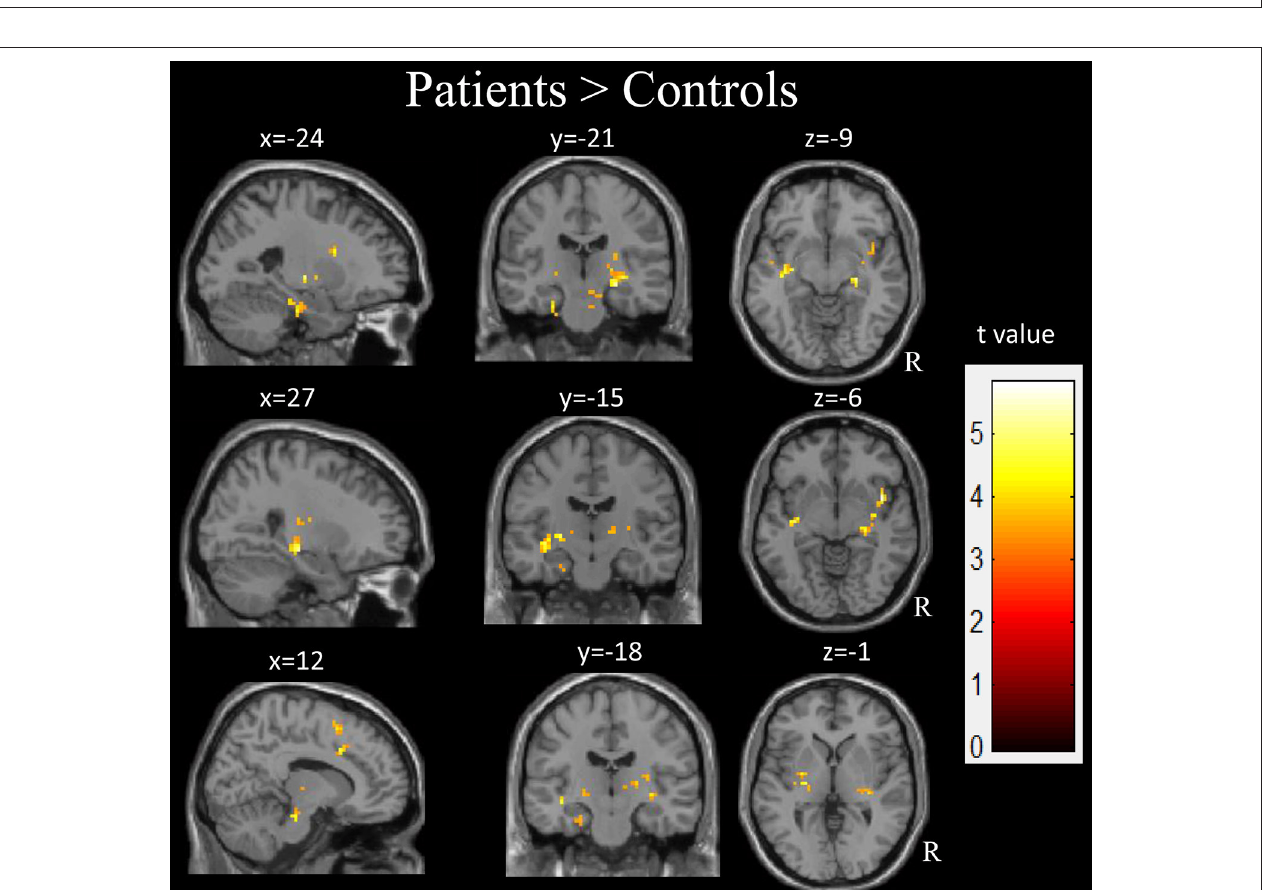
FIGURE 4 | The regions showed the significant increase of fALFF in the children with GTCS. R, right hemisphere.